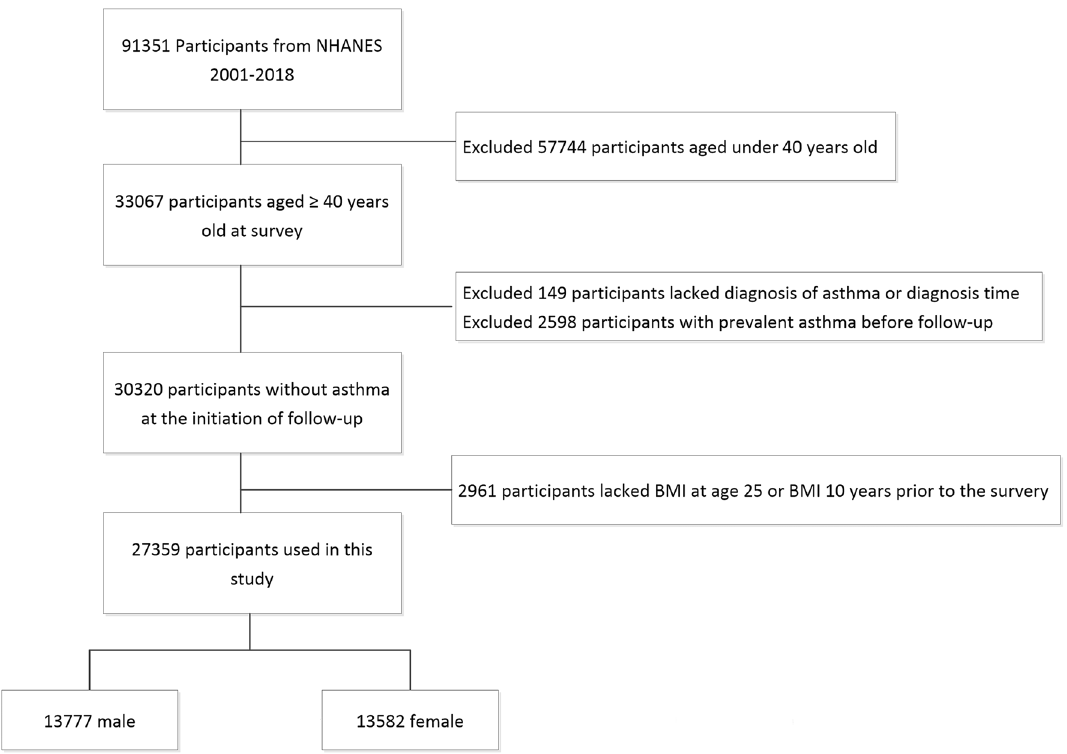
Figure 1. Study inclusion/exclusion criteria for analytic sample, NHANES 2001–2018.